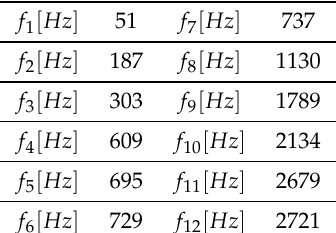
Table 3. Eigenfrequencies model B (tip